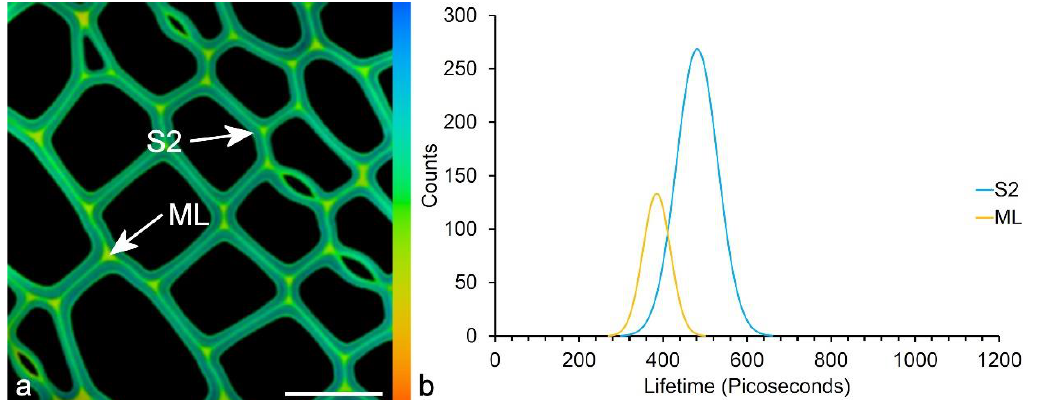
Figure 13. Fluorescence lifetime of pine lignin. ( a ) TS of pine wood showing a difference in fluorescence lifetime between the middle lamella (ML) and the secondary wall (S2). (Excitation at 405 nm.) Scale bar = 30 µm. Lifetime color scale from 0 to 1000 ps. ( b ) Fluorescence lifetime spectrum of the middle lamella (ML) compared to the secondary cell wall (S2) showing a shorter lifetime [105].